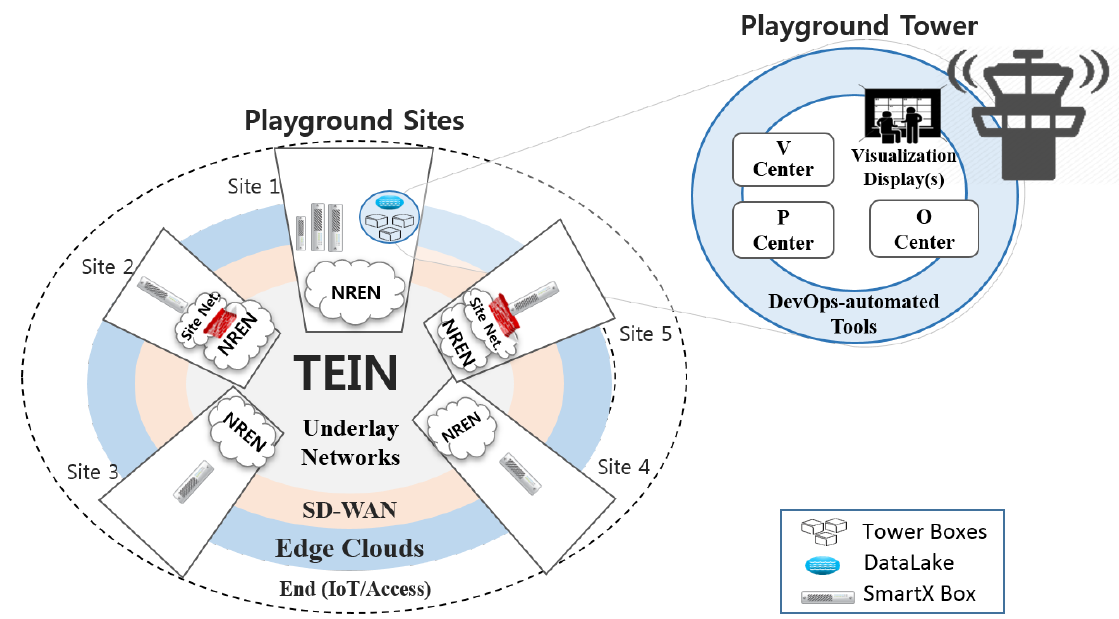
Figure 3. An SDN-Enabled Multi-Site Clouds